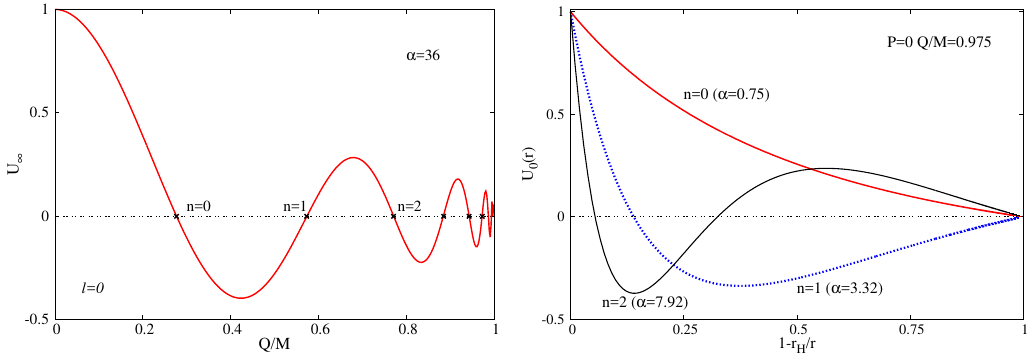
Figure 1 . (Left panel) The asymptotic value U 1 of the zero-mode amplitude U for (cid:11) = 36 as a function of the charge to mass ratio of a RN BH. An in(cid:12)nite set of con(cid:12)gurations with U 1 = 0 exist, labelled by n , the number of nodes of U ( r ). (Right panel) The pro(cid:12)les of three zero mode amplitudes U ( r ) with a di(cid:11)erent node number, for a given RN